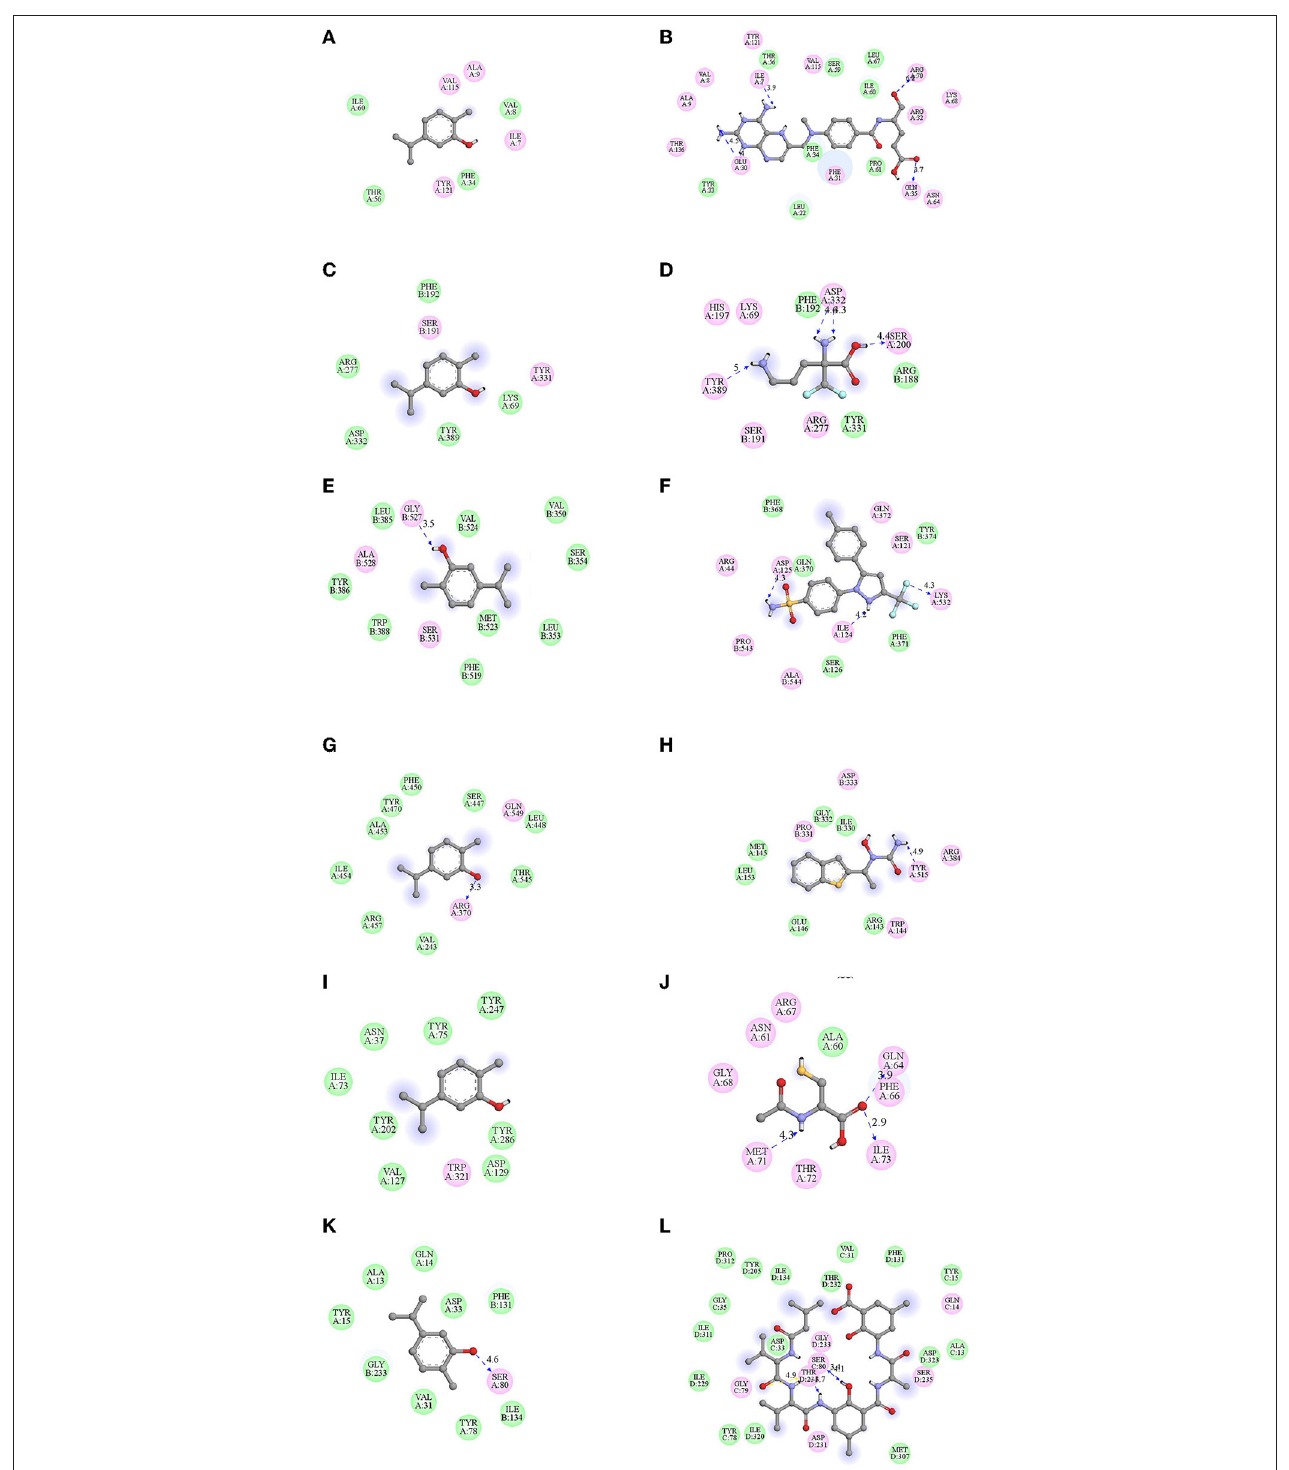
FIGURE 3 | Docked pose of carvacrol with cancer targets were visualized by chimera and their hydrophobic interactions were observed by Discovery studio. Binding energies (BE) were obtained after the docking of carvacrol with the targeted receptor/proteins from AutoVina. Their interacting amino acid residues within 4Å of protein envisaged using discovery studio (A) dihydrofolatereductase (DHFR), (B) methotrexate (MTX), (C) ODC, (D) α -difluoro methyl ornithine (DFMO), (E) COX-2, (F) celecoxib, (G) LOX-5, (H) Zileuton, (I) HYAL, (J) N-acetyl cysteine (NAC), (K) CATD, (L) pepstatin A (PEP A). Carvacrol showed strong interaction with the selected targets, but the interaction of carvacrol with ODC is, even more, more potent than standard (DFMO).